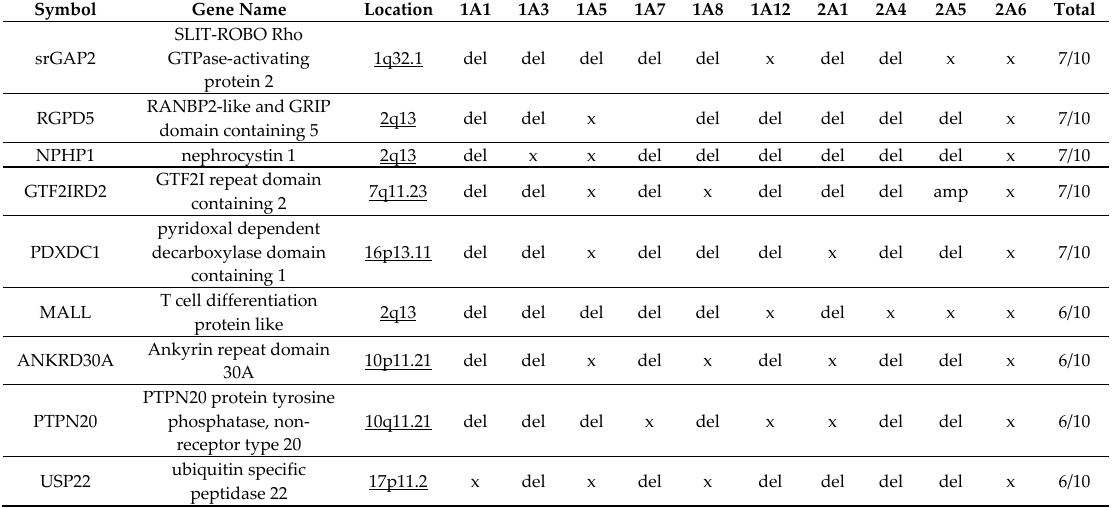
Table 2. The most common DNA copy number aberration and corresponding gene.